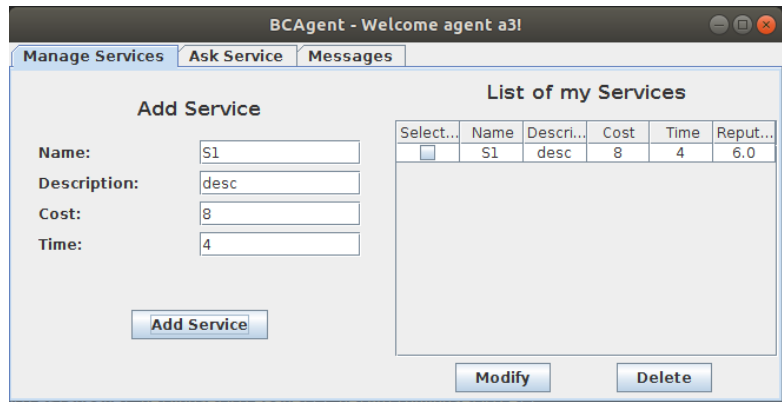
Figure 6. View to add services to the